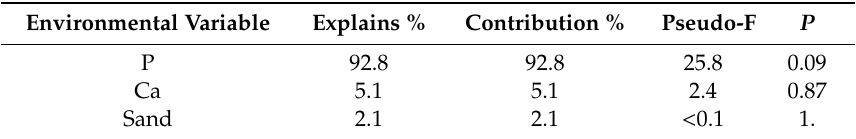
Figure 6. Canonical correspondence analysis (CCA) of functional categories and major soil chemical parameters for both samples. Table 3. Forward selection of environmental variables, which best explain variation in functional gene composition (Subsystem level 1 genes) between samples.